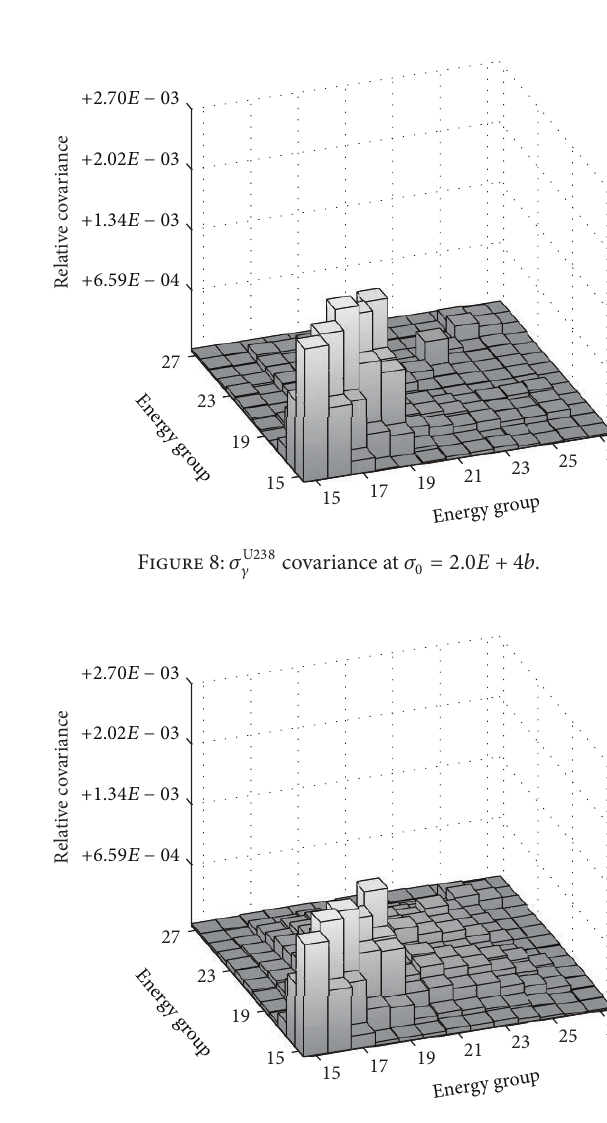
Figure 9: 𝜎 U 238 𝛾 covariance at 𝜎 0 = 52𝑏